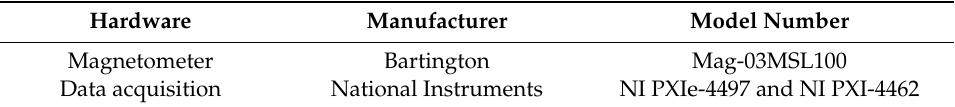
Figure 6. The experimental system. Table 1. The Specification of the Magnetometer and Data